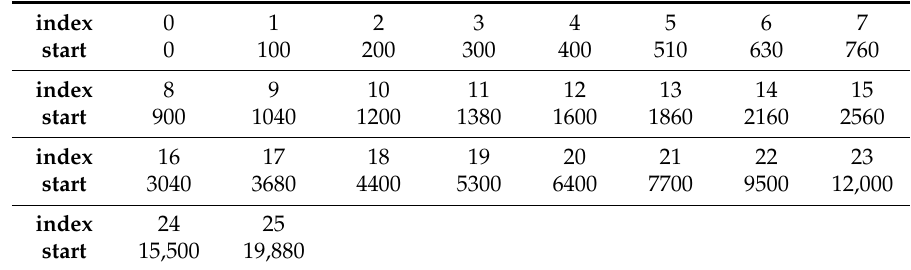
Table 4. Subband division.